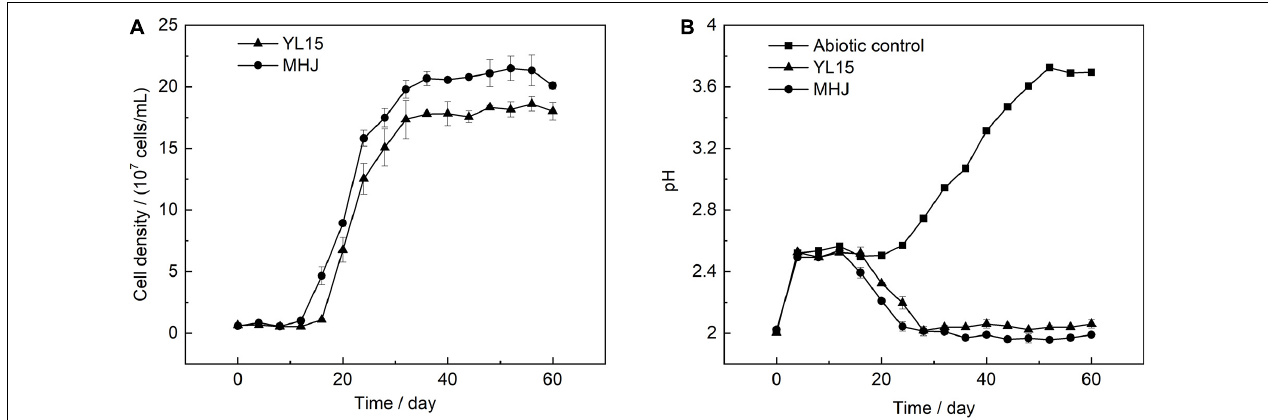
FIGURE 1 | Variations of (A) cell density and (B) pH during chalcopyrite bioleaching at 6 ◦ C. MHJ, bioleaching by the mixed culture. H 2 SO 4 (9.2 M) was added to the leaching solution to maintain the pH at ∼ 2.5 from day 4 to 16 for the bioleaching systems, and from day 4 to 20 for the abiotic control. For each bioleaching system,